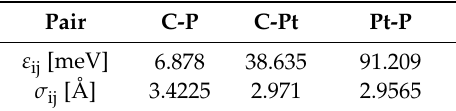
Table 1. Parameters of Lennard Jones (LJ) potential used in this simulation.